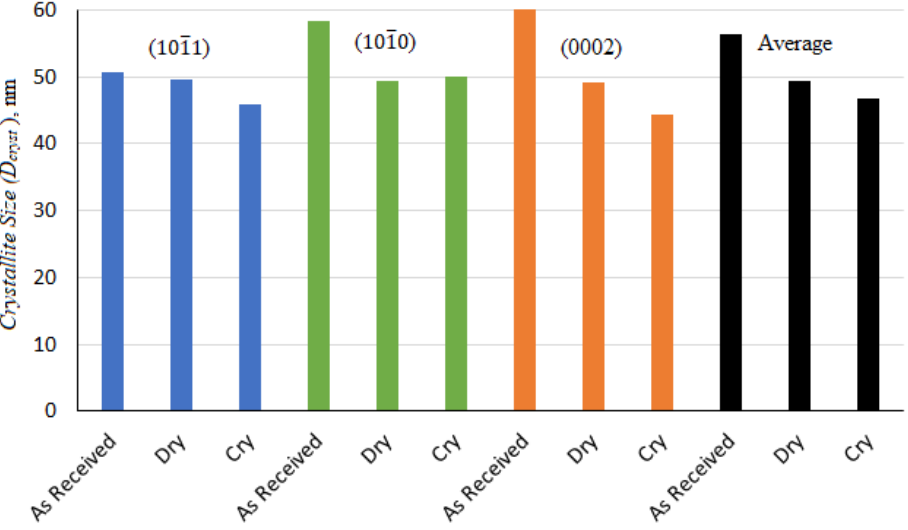
Figure 9. Crystallite size for each peak and the average crystallite size for the as-received sample, after dry turning and after cryogenic turning.